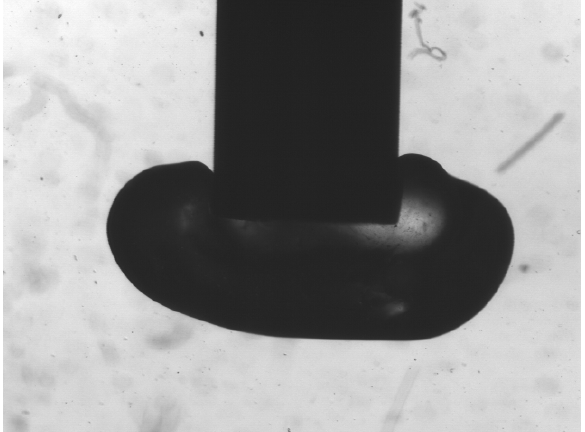
Figure 7c. Drop of PS (200,000 g/mol) in HDPE (t = 60 min) at 202 °C. Figure 7. Evolution of a pendant drop of PS (M n = 200,000g/mol) in HDPE at 202 °C.